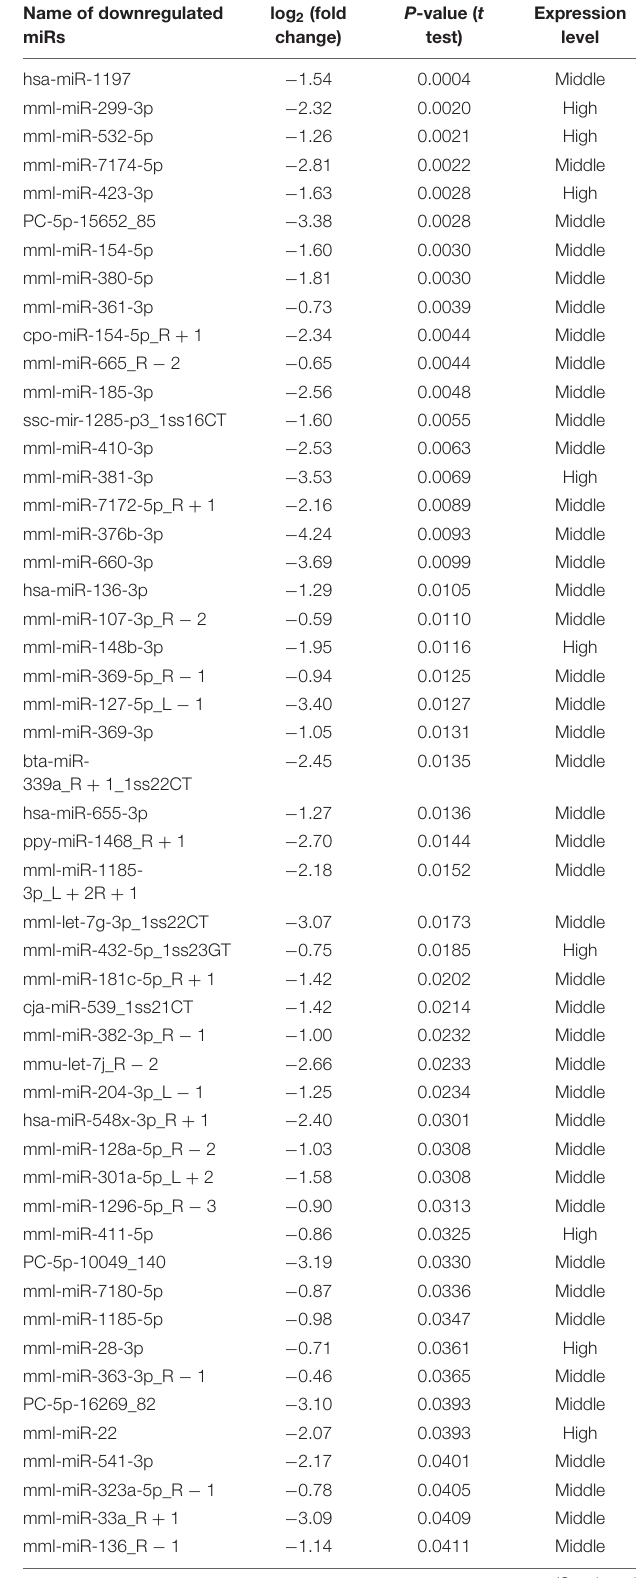
TABLE 2 | Summary information of downregulated